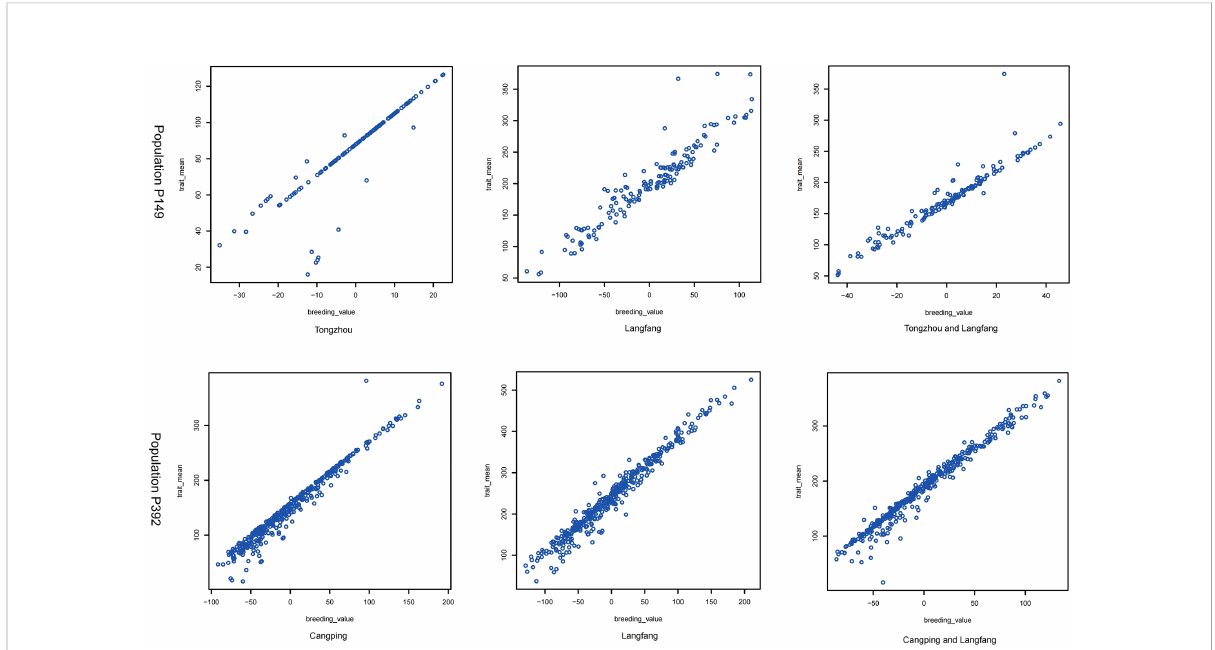
FIGURE 6 The correlation of BLUP (trait_mean, harvest phenotype value; breeding_value, BLUP phenotype value) in the P149 and P392 populations at a single location and across